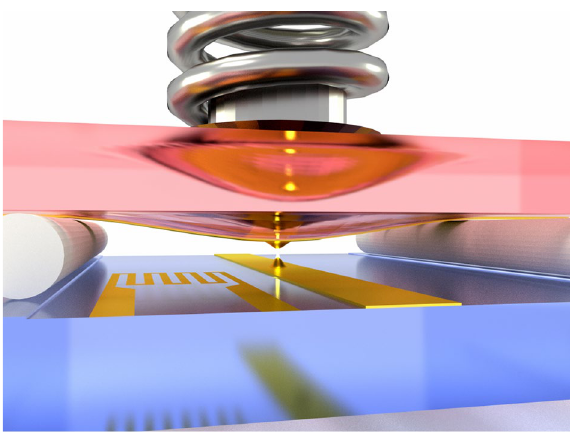
Figure 1. Scheme of the squeezable nanojunction (SNJ). Two SiC chips with electrodes are placed in a sandwich configuration. The ultra-stable distance between the electrodes is adjusted via a piezo-spring mechanism 15 . Chip temperatures T H and T C are monitored via on-chip resistance